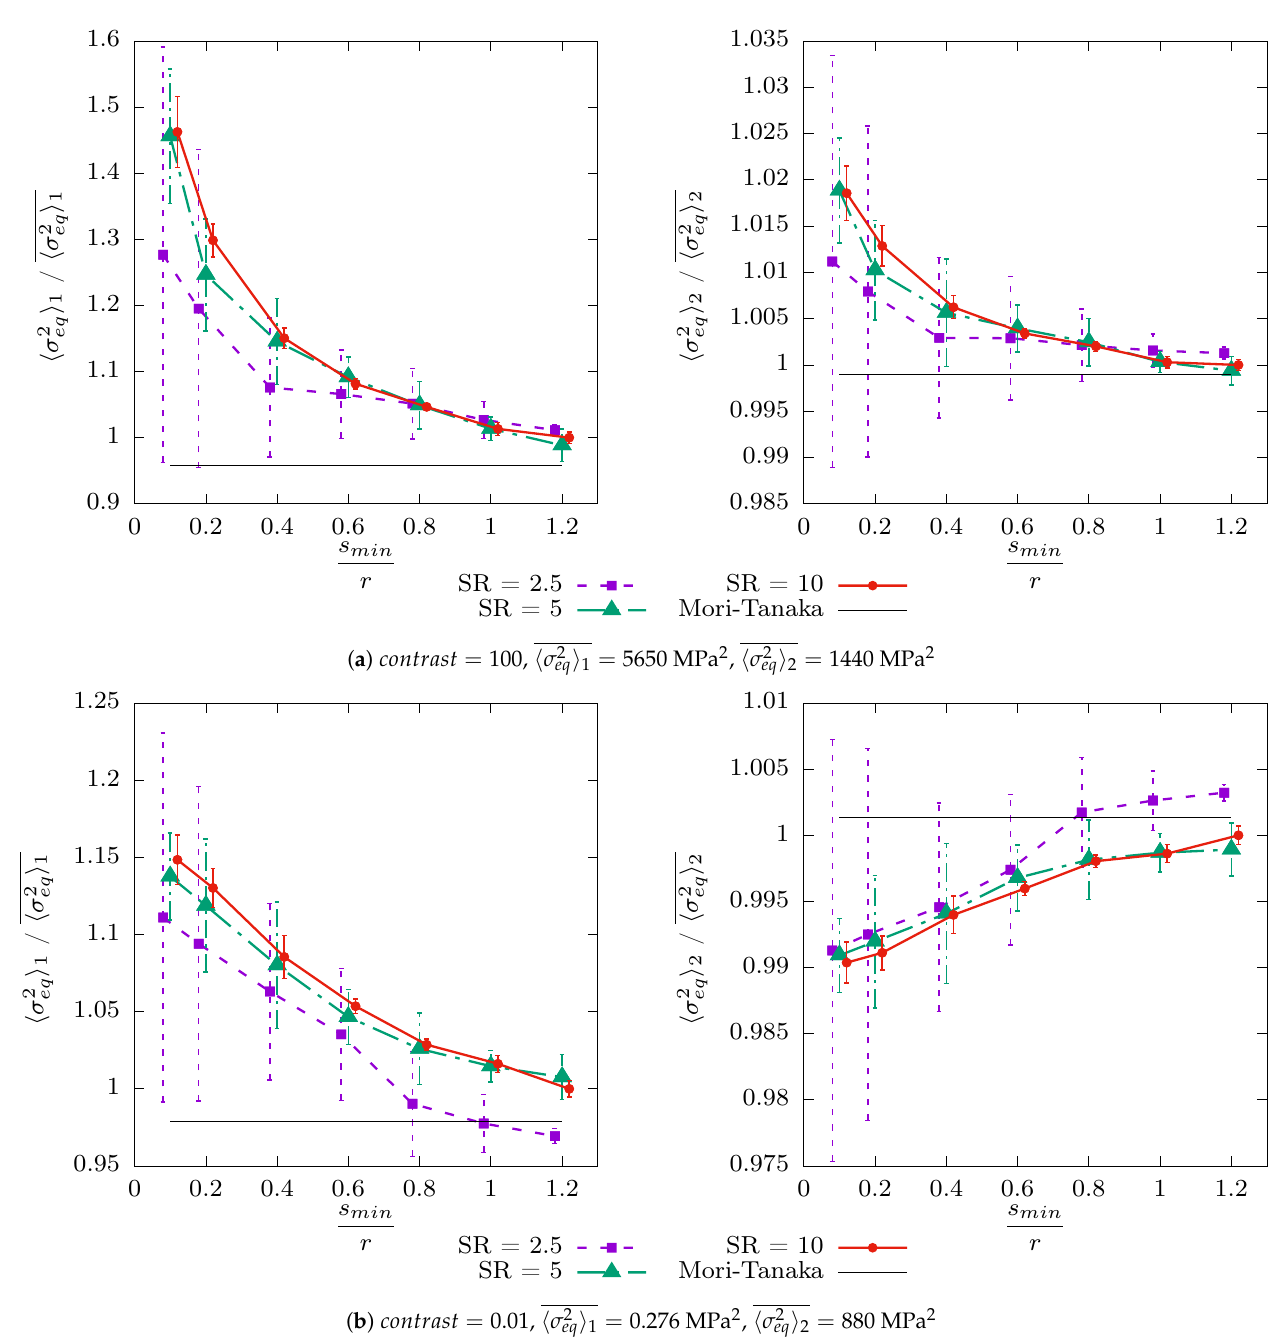
Figure 8. Mean values and standard deviations on the mean value for the second moment of equivalent stress by phase as a function of the packing parameter s min / r ( r = 10 µ m) for a volume fraction of inclusions f v = 13.4 %. For clarity, the error bars and dots are slightly shifted around for each studied minimum